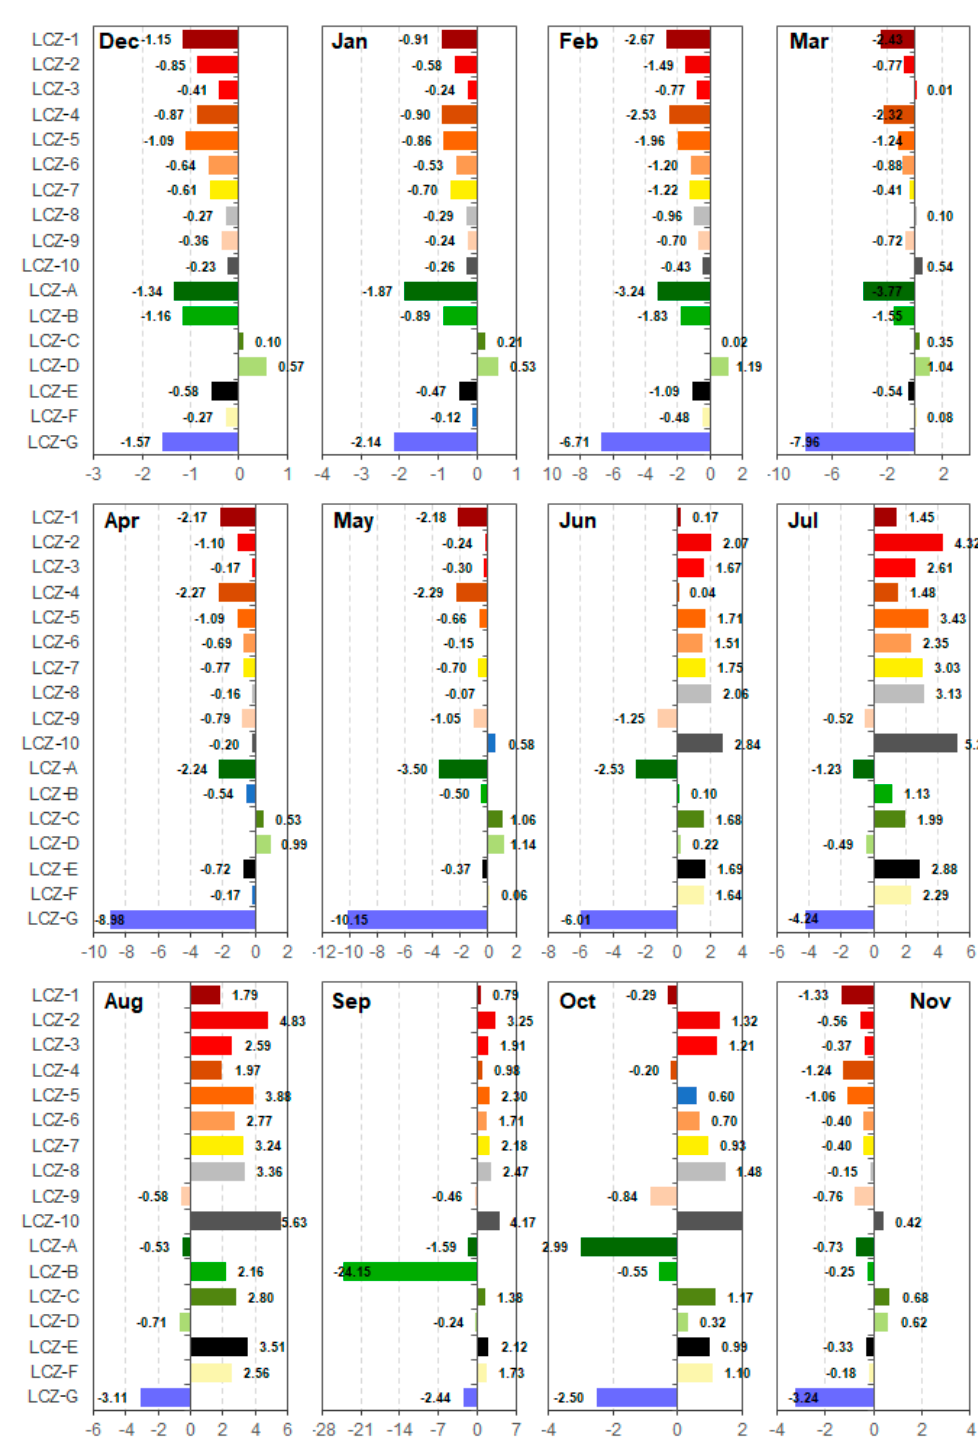
Figure A2. Deviation of the LST of Different Types of LCZs from the Average LST within a Rural Context (°C).